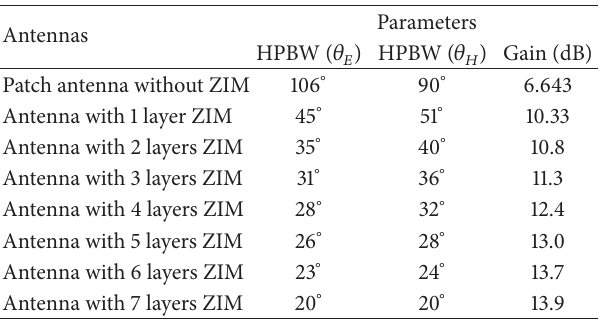
Table 1: The performances of the antenna based on the different ZIM